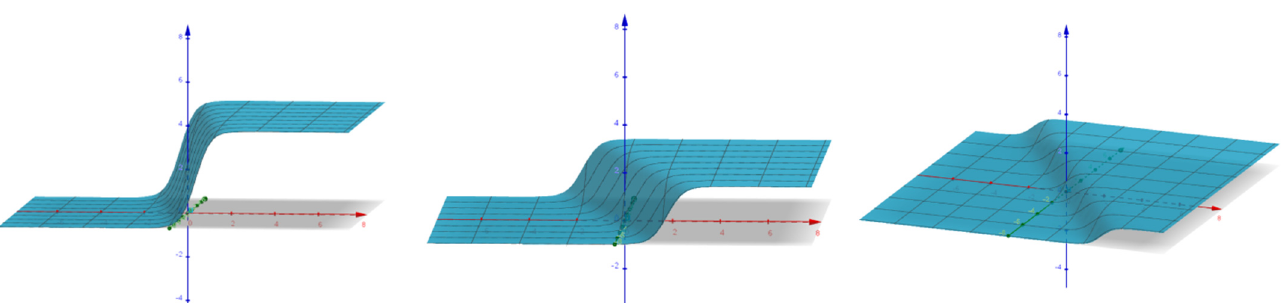
Figure 4. When n = 2, fix β = – 2 and take α as – 5, –1.5 and –0.3 respectively.